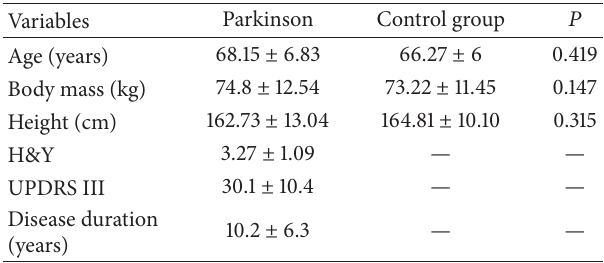
Table 1: Anthropometric